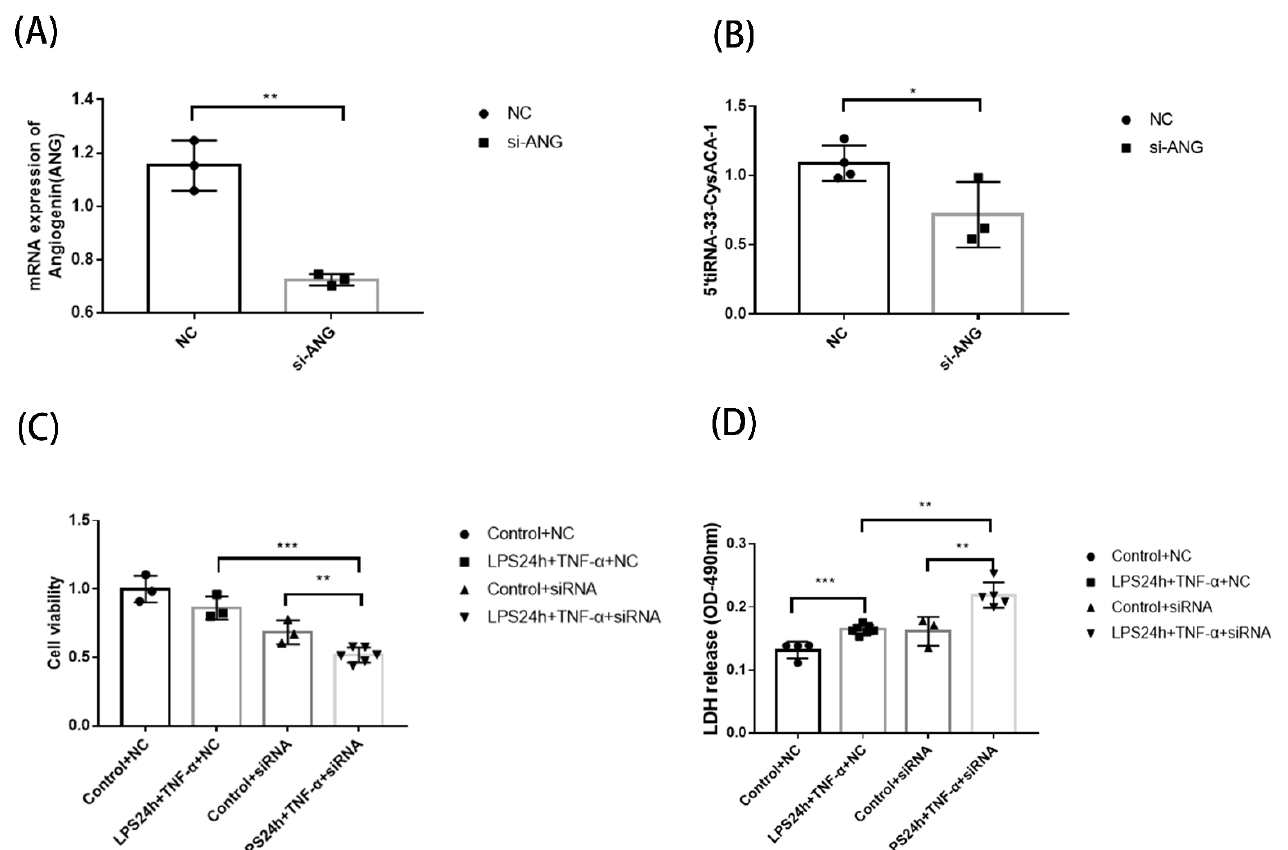
Figure 6. Function detection of septic cardiomyopathy-related tsRNAs after ANG interference. ( A ) The effect of ANG interference is detected by qPCR ( n = 3 in NC group, n = 3 in si-ANG group) ( B ) The qPCR results confirmed that the expression of 5 (cid:48) tiRNA-33-CysACA-1 ( n = 4 in NC group, n = 3 in si-ANG group) changed after ANG was interfered. Data were presented as mean ± WB standard deviation. * p < 0.05 compared with the NC group. ( C ) The effect of si-ANG on cell viability after 24 h of LPS + TNF- α treatment ** p < 0.01; *** p < 0.001 compared with the Control group. ( D ) The effect of si-ANG on the release of LDH (cell death) after 24 h of LPS + TNF- α treatment ** p < 0.01; *** p < 0.001 compared with the Control group. si-ANG: ANG-specific siRNA; NC: negative control; qPCR: Quantitative real-time PCR; tRF: tRNA fragments; tiRNA: tRNA halves; tsRNA: tRNA-derived small RNA.